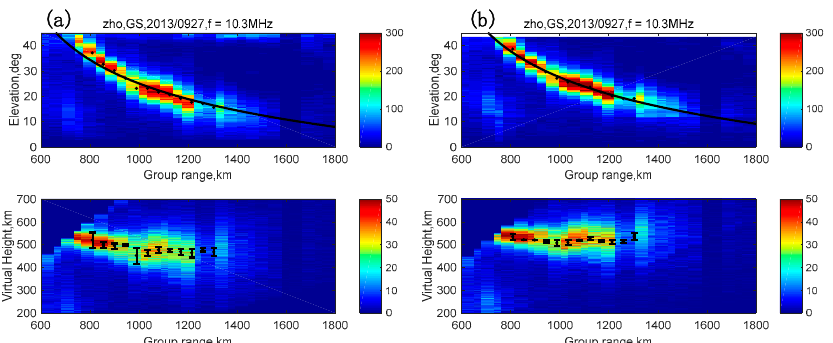
Figure 3. The virtual height distribution of ground backscatter echoes for range gate 24 (1215–1260 km) at the Zhongshan radar in September 2013. The black line represents the actual virtual height calculated by the elevation angle and group range, and the red line represents the result of fitting with a Gaussian function.